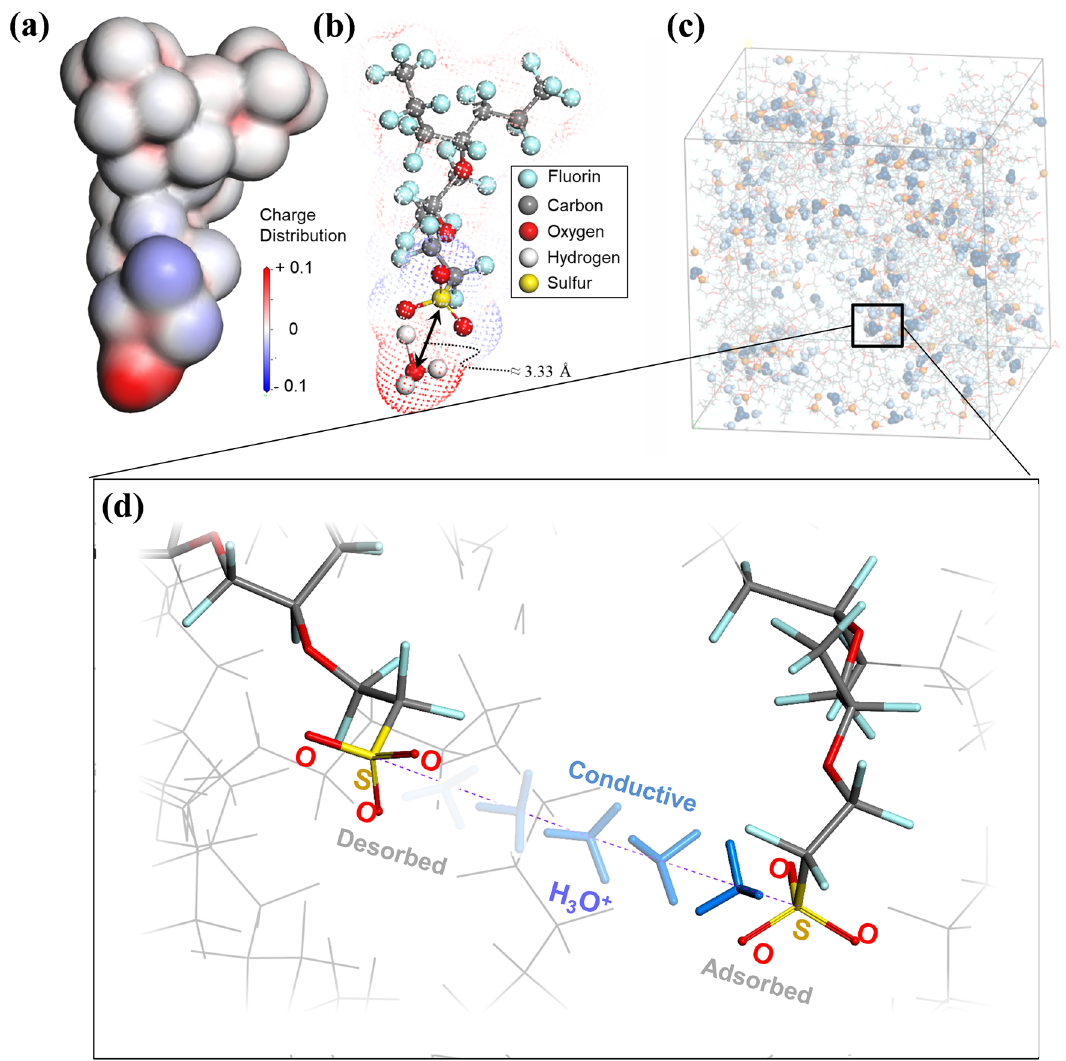
Figure 3. ( a ) A snapshot of charge distribution, and ( b ) structure of side chain with hydronium representing the adsorption distance; ( c ) the system of molecular dynamics simulation for the PEMFC. ( d ) The distance criterion used to evaluate the state of a cation (H 3 O + ) near a negatively charged sulfur atom. Cation status (adsorbed or conductive) was determined by reference to the distance with the lowest energy level, as revealed by density functional theory. Cations associated with larger distances from the sulfur atom were considered to be ineffective and were excluded from